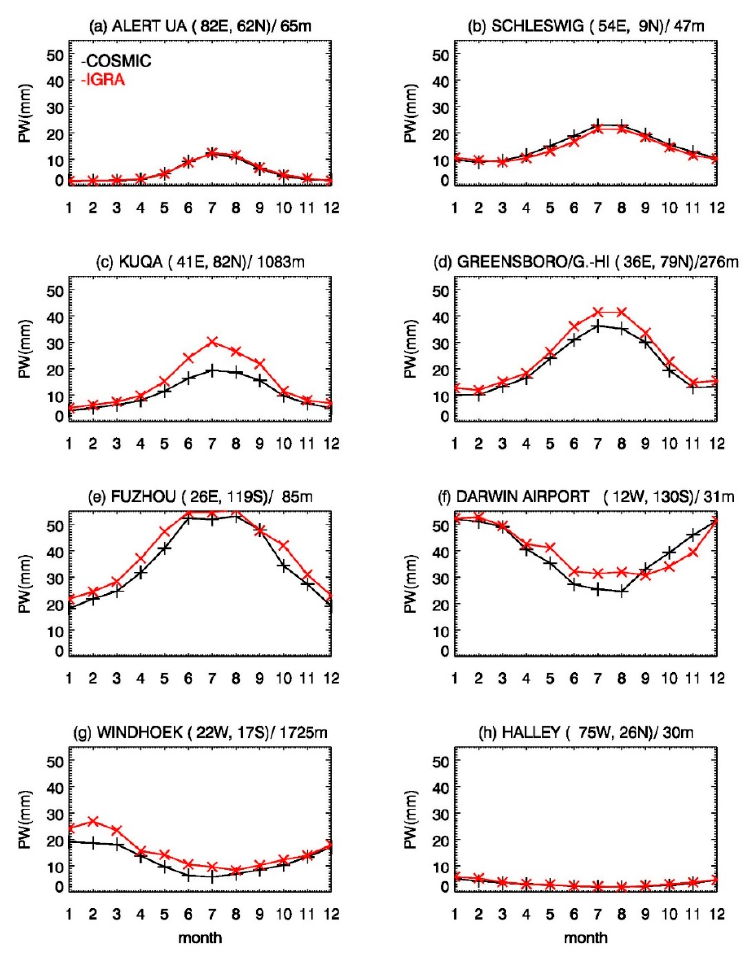
Figure 2. Variations of monthly mean precipitable water (PW) of selected stations ( a – h ) retrieved from Constellation Observing System for Meteorology, Ionosphere, and Climate (COSMIC) and Integrated Global Radiosonde Data (IGRA) observations for the period of